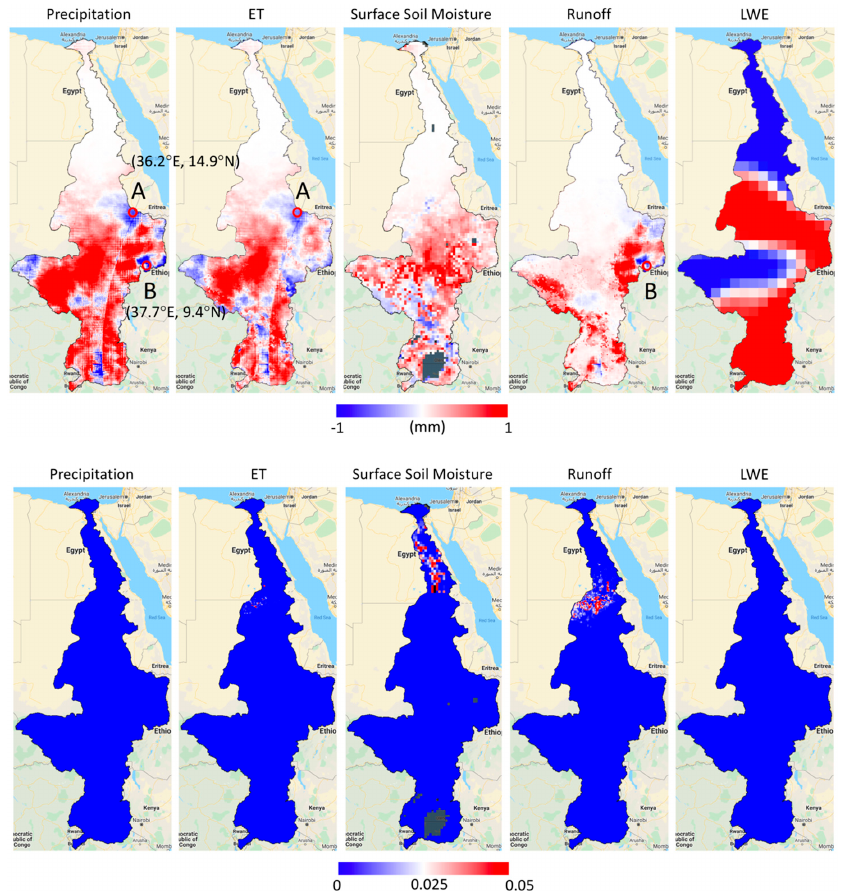
Figure 3. Changing trends of multiple hydrological factors (precipitation, evapotranspiration (ET), surface soil moisture, runoff and equivalent liquid water thickness (LWE)) over the Nile watershed calculated based on harmonic analysis of the periods between the years 2002–2017 (first row), as well as the degree of significance test using p-value (second row) (Note: surface soil moisture trend is calculated using the averaged value of the period 2010–2017 due to data availability).